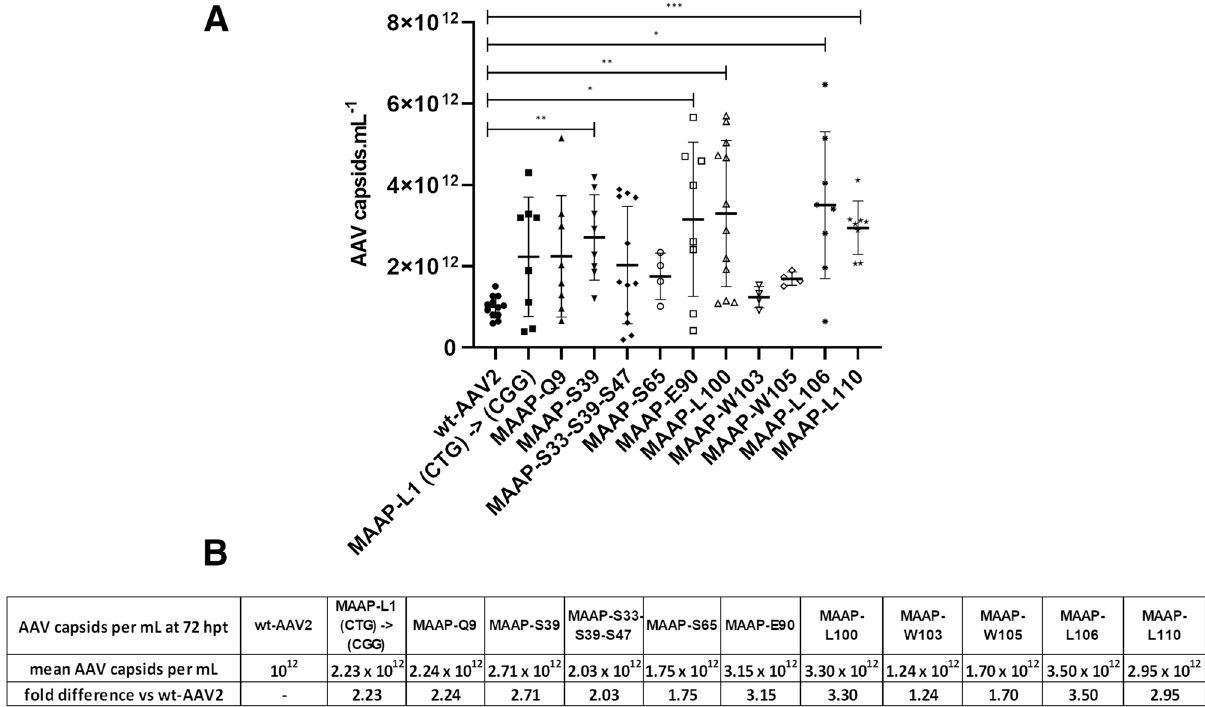
Figure 8. MAAP effects on capsid levels. Plasmids with wt-AAV2 or AAV2 encoding MAAP variants were co-transfected with Ad helper plasmid. From cell extracts harvested 72 hpt, we performed AAV2 capsids ELISA ( A ), expressed as AAV capsids per mL with mean and the standard deviation (SD). Statistical significance between wt-AAV2 and AAV2 encoding MAAP mutants was evaluated using ANOVA followed by Dunnett’s multiple comparison test. Table ( B ) indicates the average AAV per mL capsid titer measured for each virus, along with the fold difference compared to